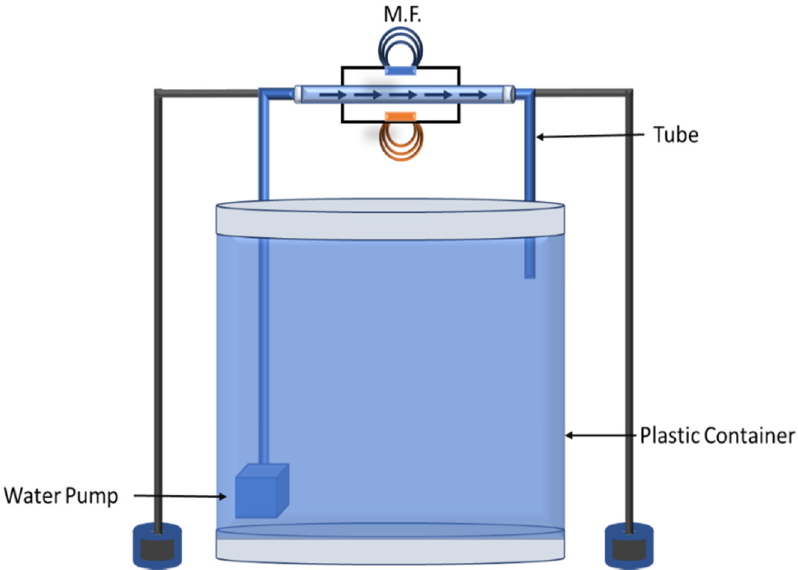
Figure 3: Schematic diagram of the MF system.